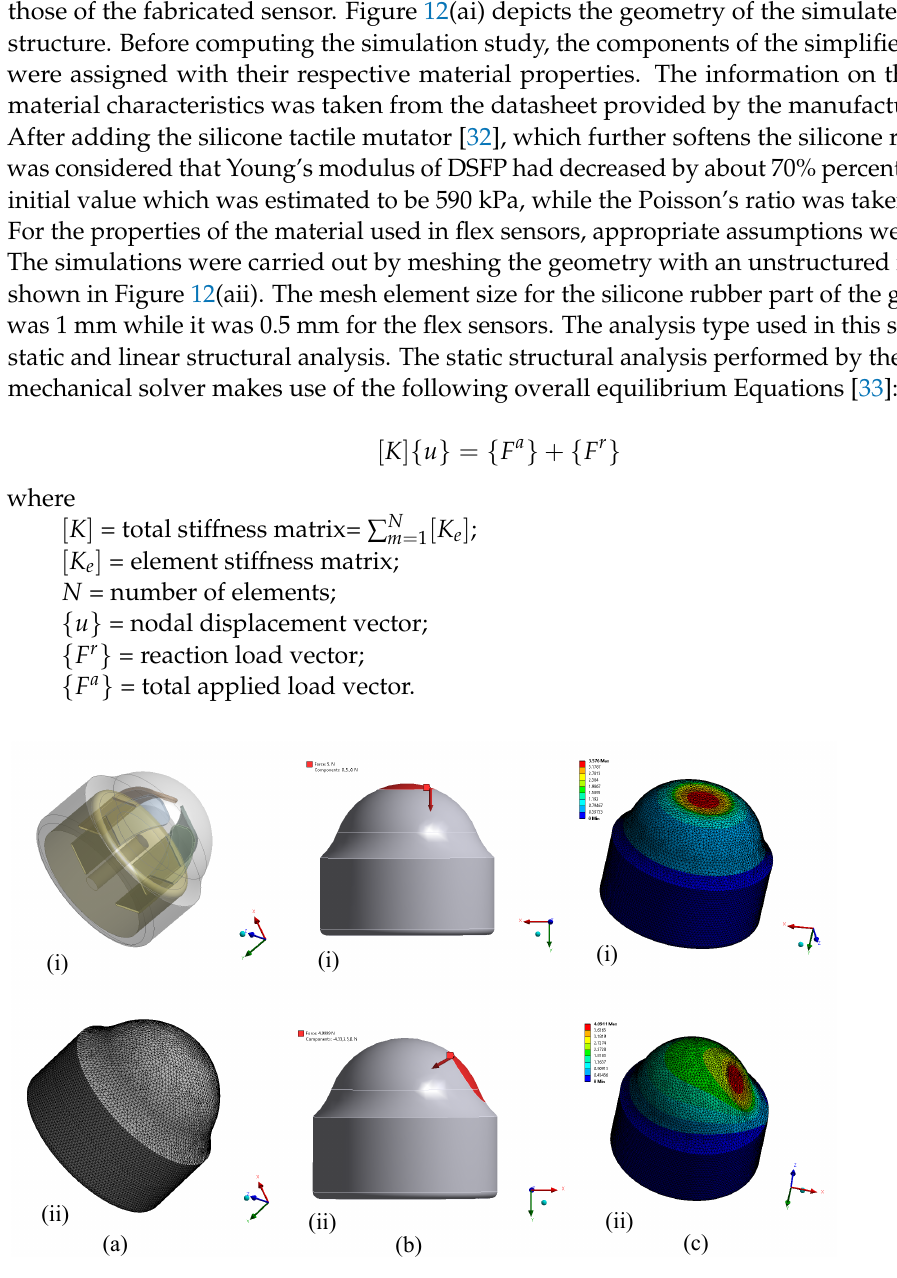
Figure 12. Steps to simulate the sensor shell deformation: ( a ) ( i ) geometry of the sensor and ( ii ) unstructured mesh, ( b ) direction and location of the applied forces: force parallel to ( i ) vertical or y -axis at 90 ◦ latitude and ( ii ) 60 ◦ to the vertical at 30 ◦ latitude, and ( c ) contour of total deformation